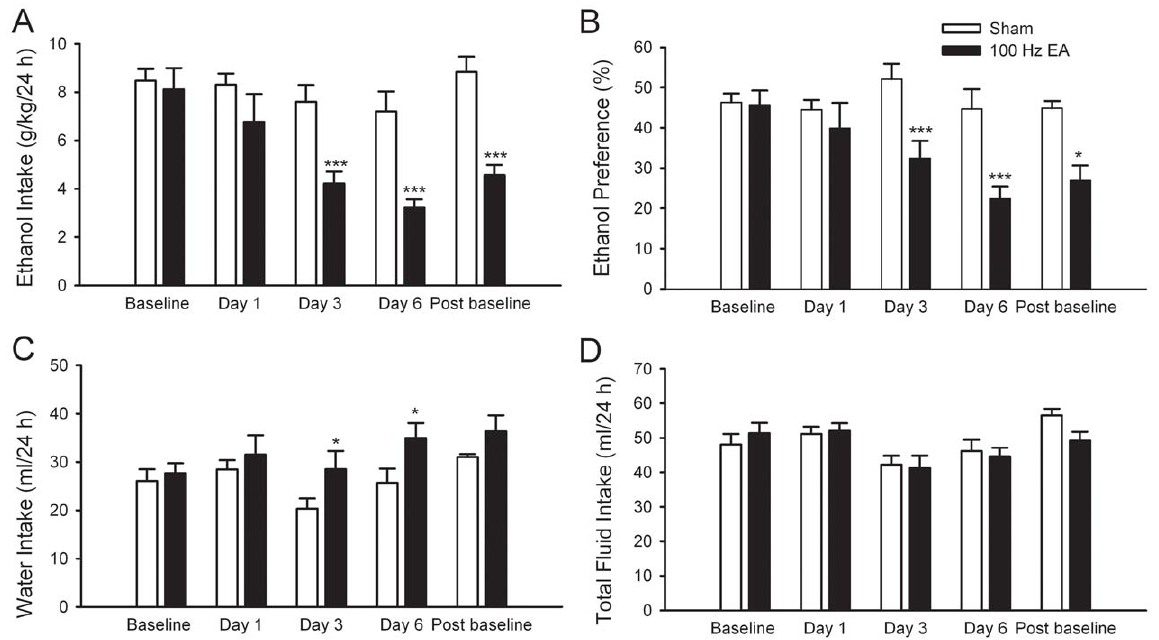
Figure 2. Multiple sessions of high frequency (100 Hz) EA sharply decreased excessive consumption of and preference for ethanol. 100 Hz EA or sham was administered to two different groups of rats for 6 consecutive days, 10 min before the start of ethanol- or water-drinking session. The effect was measured on day 1, 3, and 6. There was no significant difference regarding the baseline drinking levels between the EA and the sham group. Rats in EA group (filled bars) but not in sham group (blank bars) sharply reduced ethanol intake (g/kg/24 h) ( A ) and preference ( B ) for ethanol at the 24 h after the onset of drinking. EA treatment also increased water intake ( C ). Total fluid intake was not affected by multiple EA treatment at 24-h time point on all test days ( D ). The values are expressed as mean 6 SEM. * p , 0.05, *** p , 0.001 compared with sham (two-way RM ANOVA followed by Tukey post hoc analysis), n=8 animals in each group.